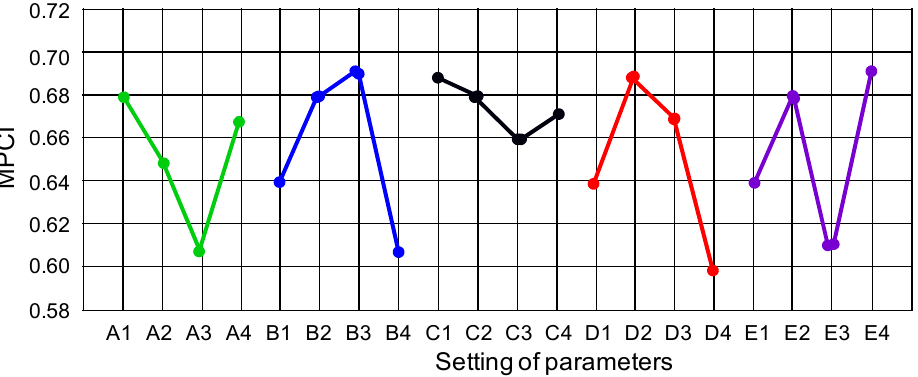
Figure 2. The MPCI values for five control factors with respect to the corresponding levels.